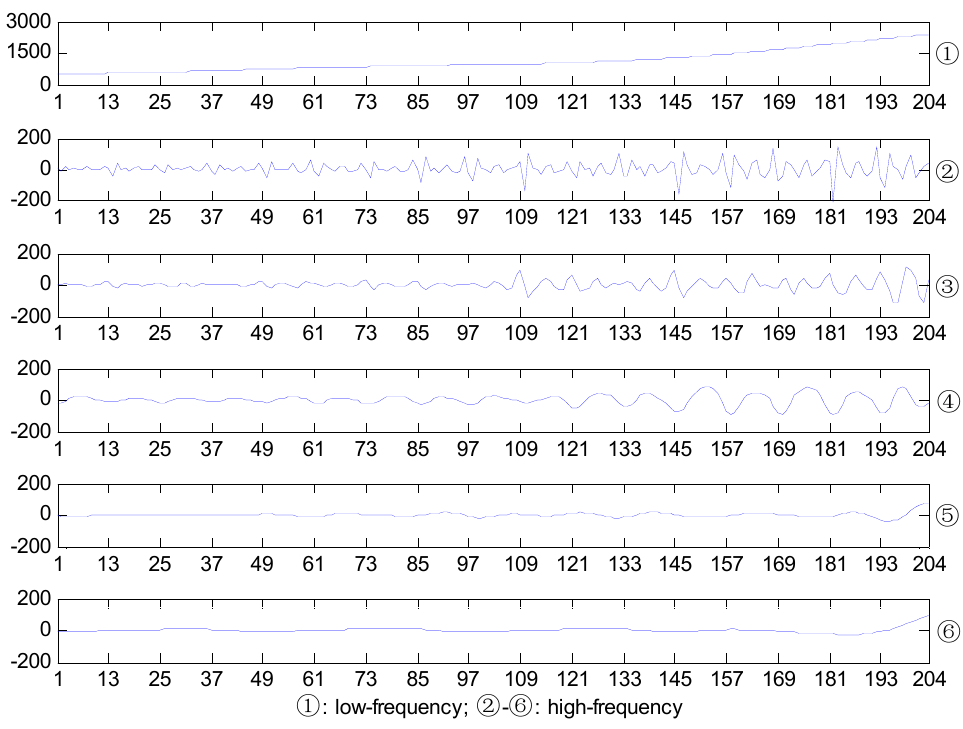
Figure 4. Results of db(5) wavelet